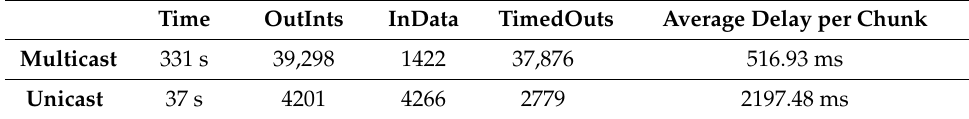
Table 6. Total download time using multi-technology and pipelined